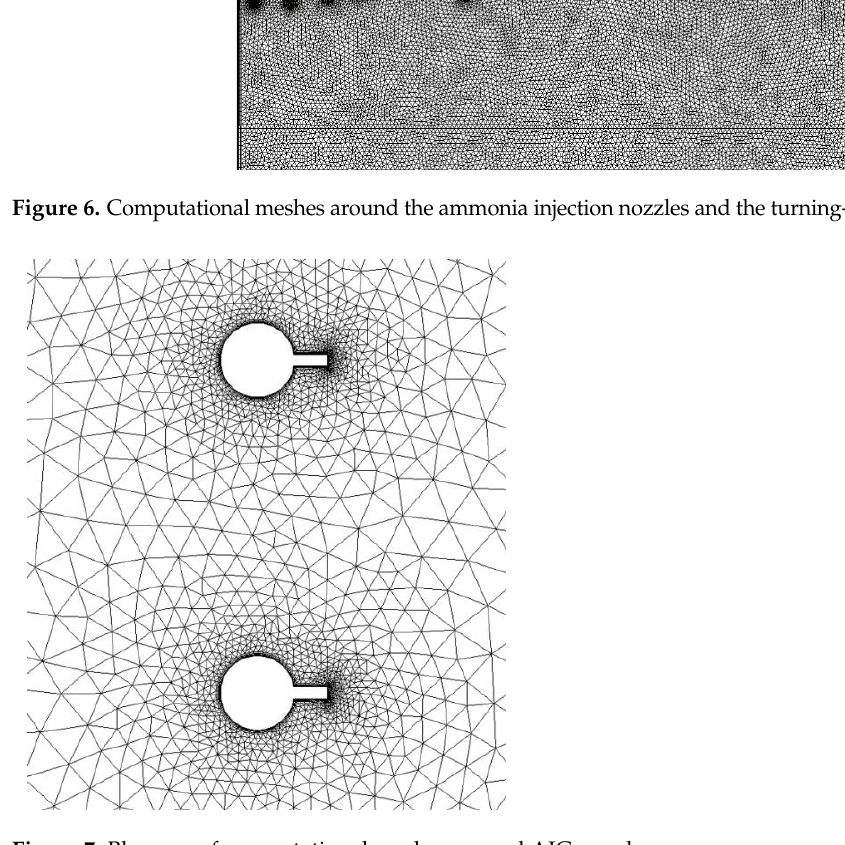
Figure 7. Blow-up of computational meshes around AIG